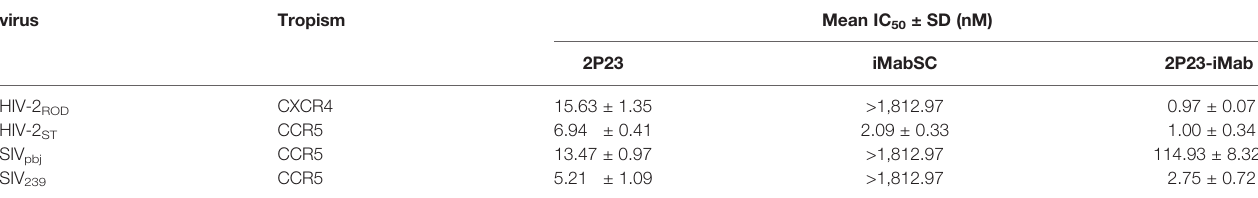
TABLE 5 | Inhibitory activities of 2P23-iMab and its template inhibitors against HIV-2 and SIV isolates.